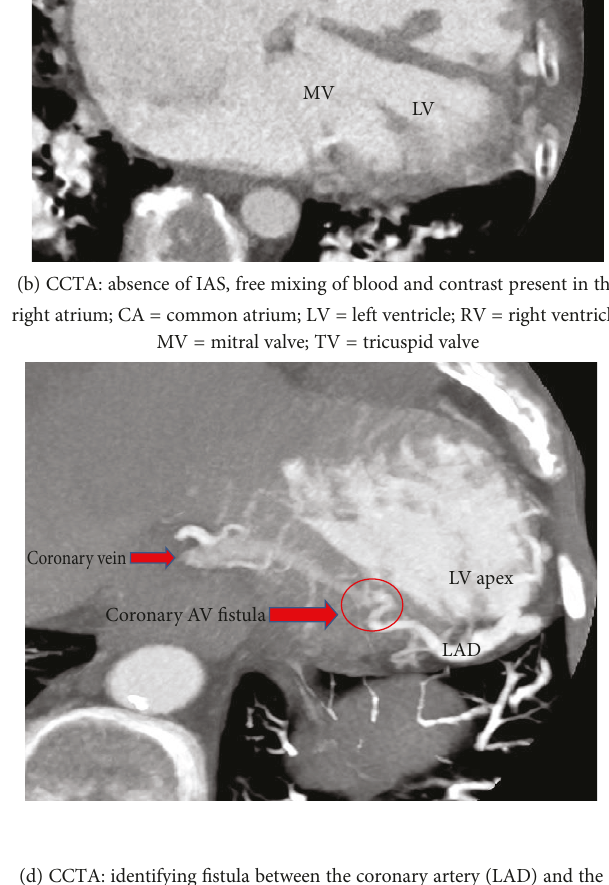
Figure 2: Cardiac computed tomography angiography images. (a) Absence of the atrial septum (arrow). (b) Absence of interatrial septum showing free mixing of blood and contrast present in the atrium. (c) Common atrium with normal pulmonary connections, dilated pulmonary artery, and ectatic/aneurysmal left anterior descending artery. (d) Identifying fi stula between the coronary artery and the coronary